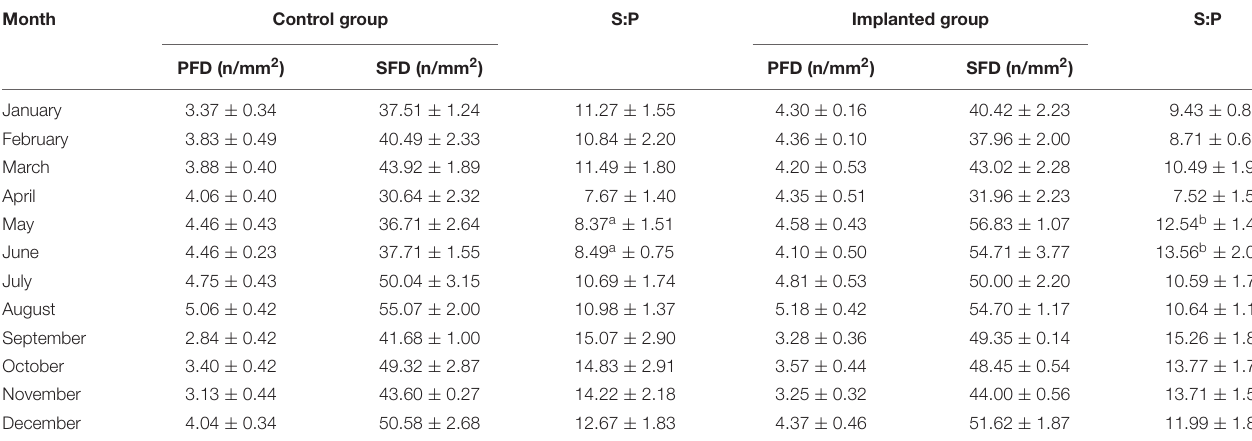
FIGURE 3 | Transverse incision of skin follicles of Inner Mongolia cashmere goats in May, June, and September. M represents trial group and K represents control group. The numbers 5, 6, and 9 represent May, June, and September, respectively. TABLE 1 | Effect of administration of melatonin to cashmere goats in one cashmere growth cycle on primary and secondary hair follicle numbers. Month Control group S:P Implanted group